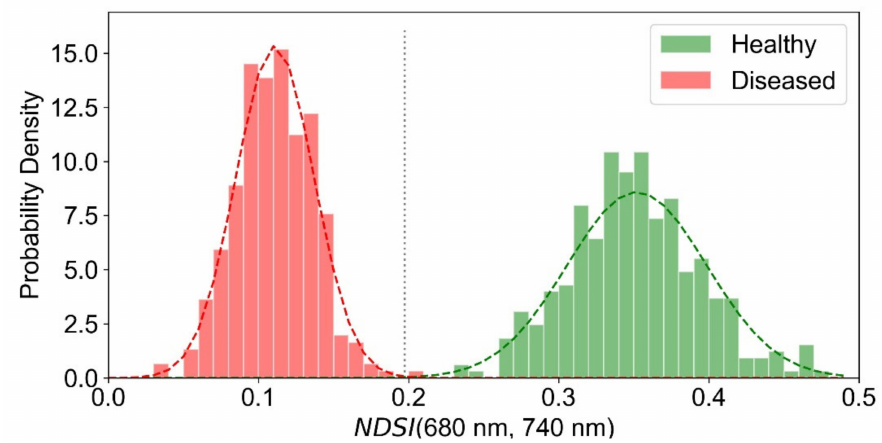
Figure 4. Probability density distribution of the healthy and diseased areas for NDSI (680 nm, 740 nm). Green and red dashed curves are fitted to the probability density distributions of the healthy and diseased areas, respectively, assuming a normal distribution. The vertical dotted line represents the threshold value of the NDSI at which the Mahalanobis distances from the two normal distributions are equal.